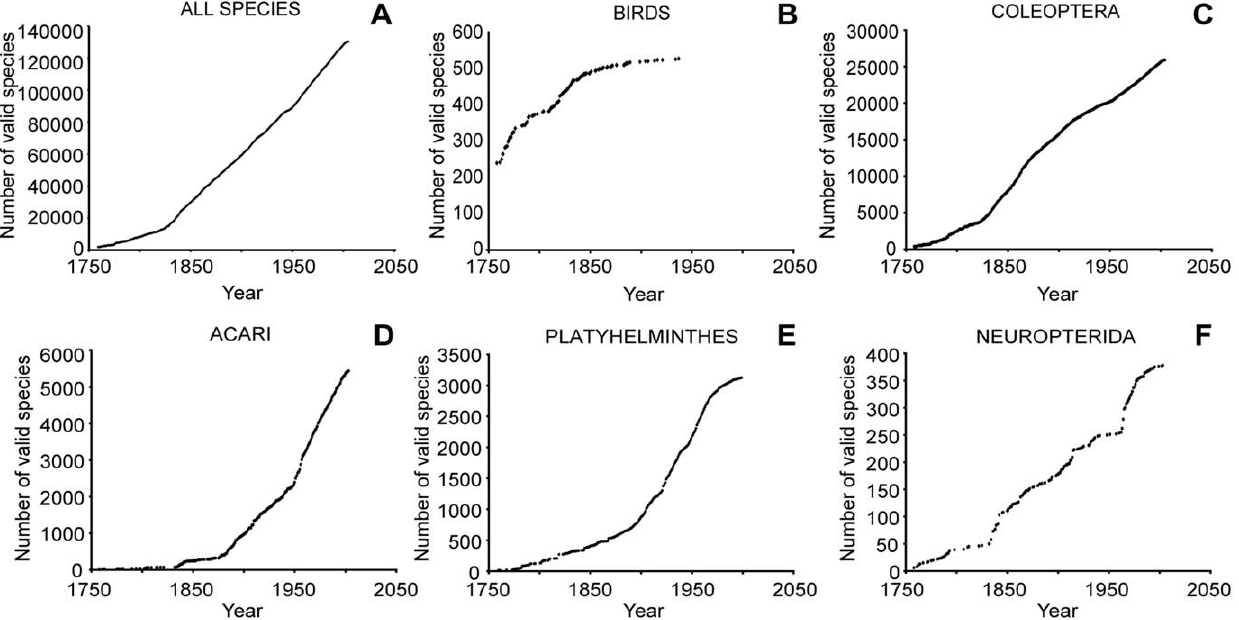
Figure 1. Growth of the European taxonomic inventory. Cumulative number of valid species of European terrestrial and freshwater multicellular species since Linnaeus. A: All species. B: Birds, a virtually completely inventoried compartment of European biodiversity. C: Coleoptera, where the number of valid species has steadily increased and shows no sign of levelling. D: Acari, which remained neglected for two centuries, and are now exhibiting a high discovery rate. E: Platyhelminthes, where the impression of a saturated inventory could be due to a current lack of taxonomic workforce. F: Neuropterida orders, for which the rate of description is erratic and reflects bursts of activity by a handful of taxonomists.